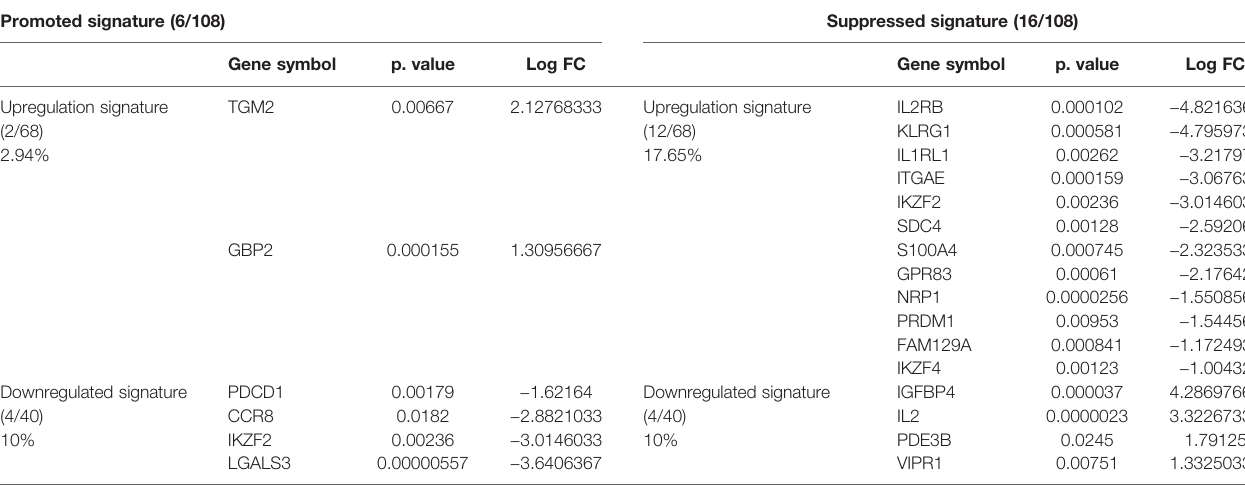
TABLE 8B | The expression changes of Treg signature genes including 68 upregulated signature genes and 40 downregulated signature genes were identi fi ed to determine whether Il2rb could modulate